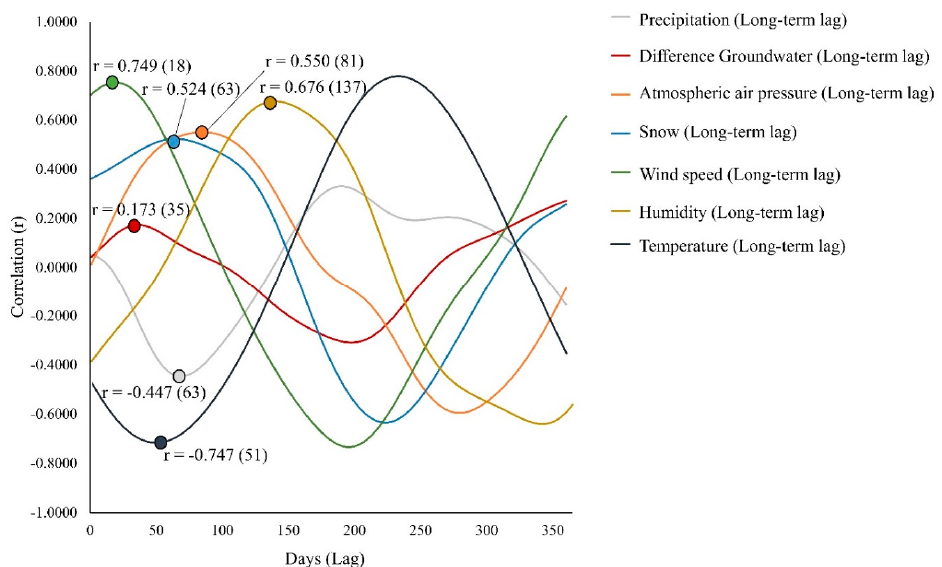
Figure 6. Determination of the strongest correlation (positive or negative) between the water discharge and the lagged hydrogeological and climatic variables for the long-term component. The strongest correlation between the water discharge and the predictor variables is equal to − 1 or 1, while the weakest correlation occurs when the value is 0. The shaded points represent the strongest correlation value.